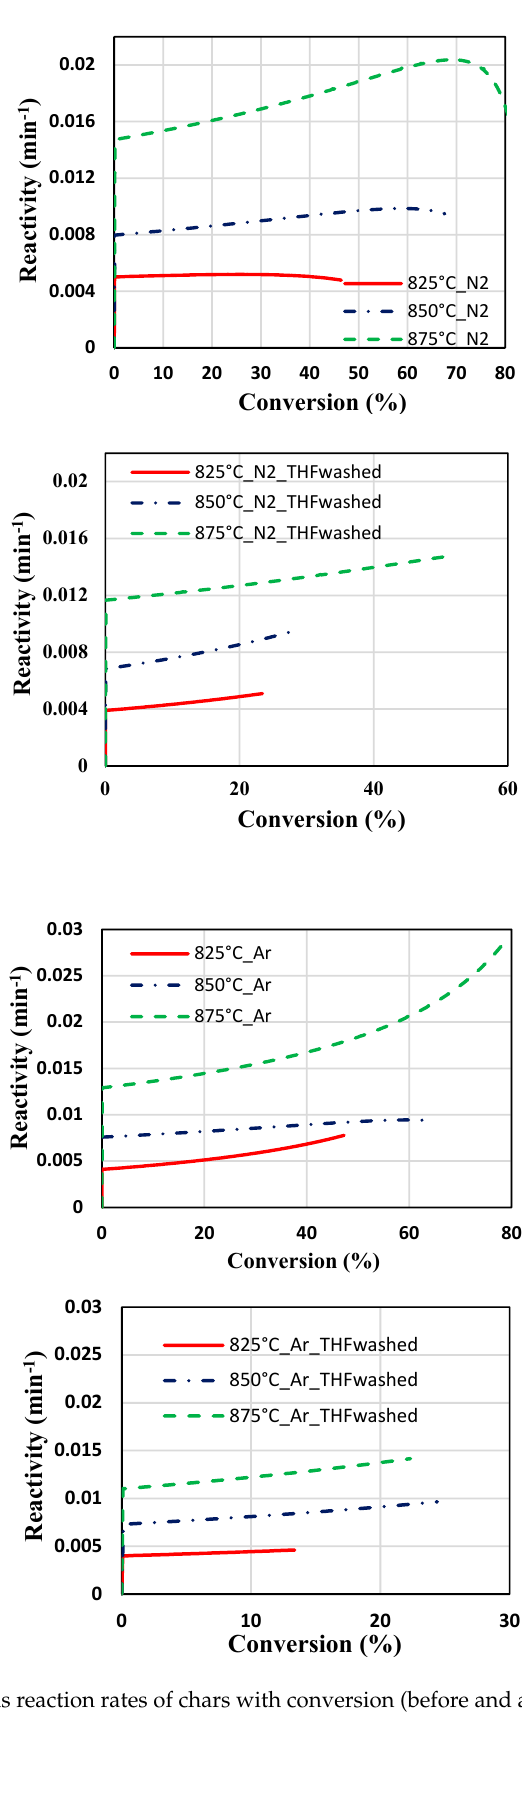
Figure 12 . Instantaneous reaction rates of chars with conversion (before and after washing with THF).